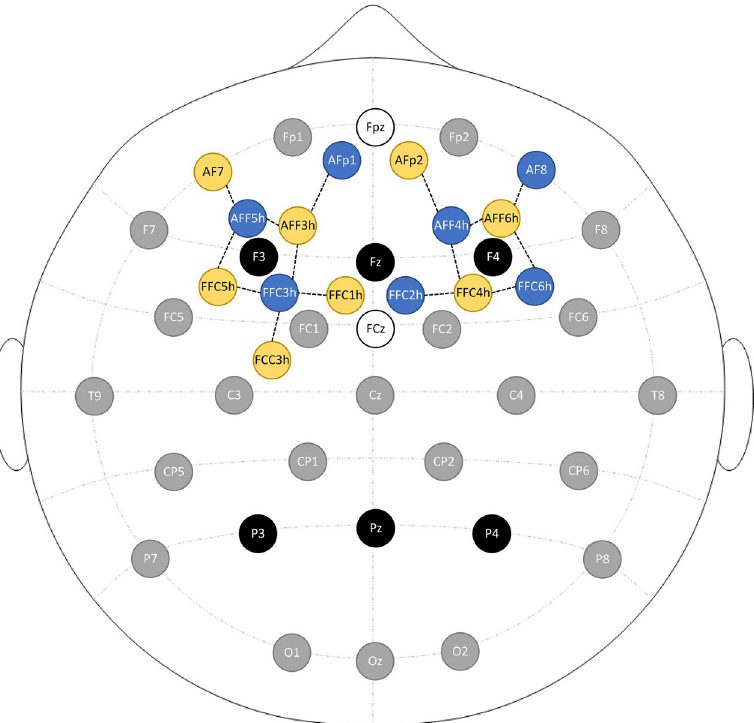
Figure 4. Combined EEG-fNIRS montage. Black = electrode used in analysis, grey = electrode not used in analysis, white = reference and ground electrodes, blue = fNIRS detector, yellow = fNIRS source incl. short distance channel, dashed lines = fNIRS